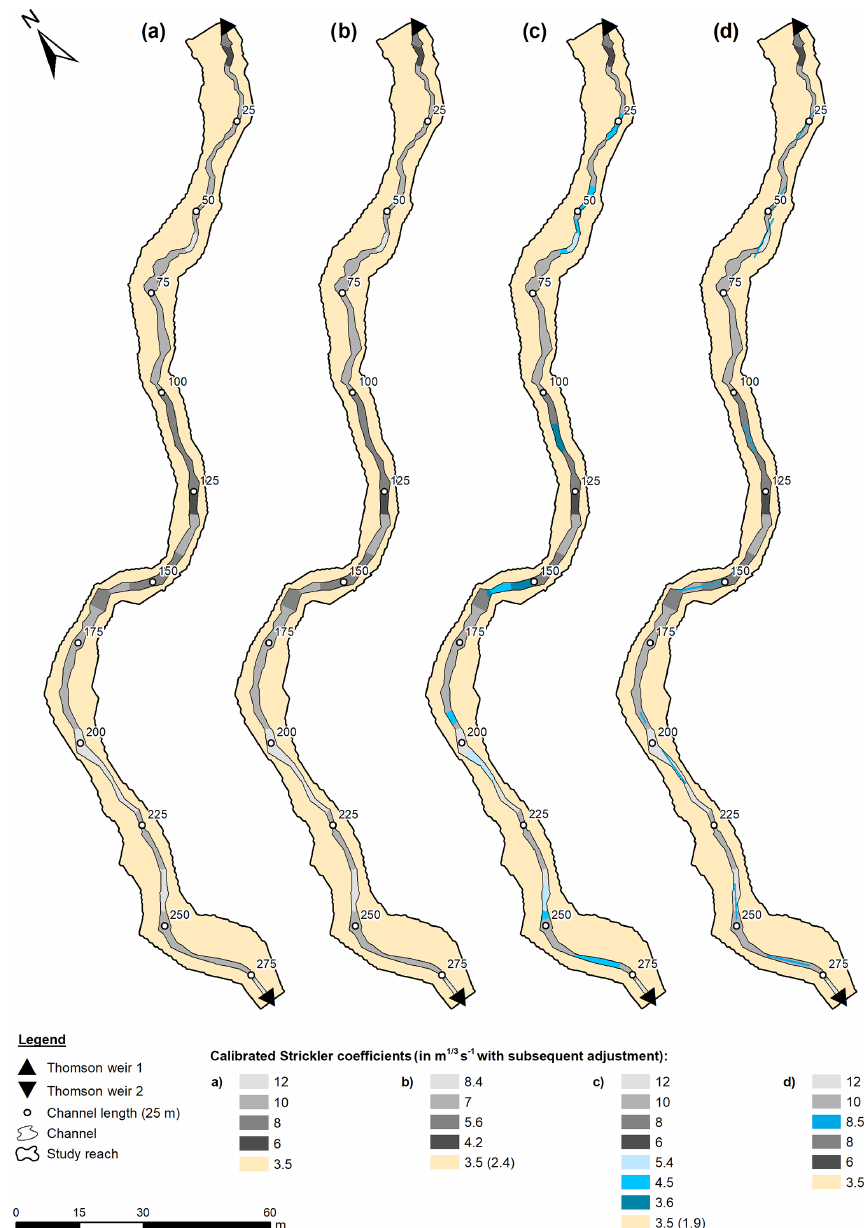
Figure 6. Distribution of calibrated roughness coefficients of all simulation variants with and without LW in the study reach: (a) reference variant RV without LW, (b) variant V1 with stable LW as an increase of roughness in the entire channel, (c) variant V2 with stable LW as an increase of roughness at element positions only and (d) variant V3 with LW as discrete topographic elements of the calculation mesh. If displayed, values in parentheses represent the Strickler coefficient after subsequent